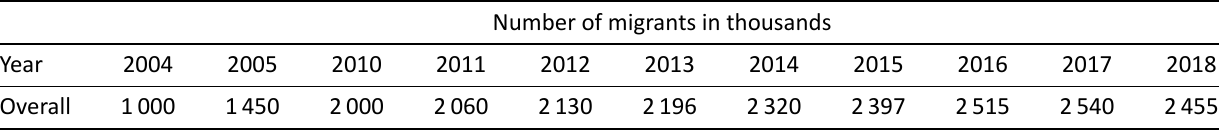
Table 1. Estimation of emigration from Poland for a temporary stay in 2004–2005 and 2010–2018 (number of people staying abroad at the end of the year).